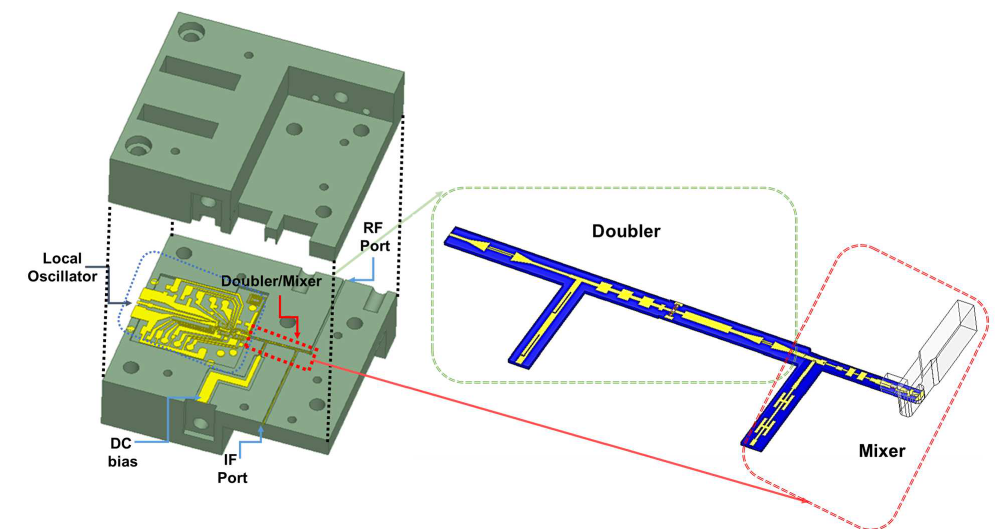
Figure 1. Explosion view of the 3D model of the combined doubler-subharmonic mixer with integrated MMIC based LO source. (Inset) 3D view of the combined doubler/harmonic mixer model without local oscillator for HFSS